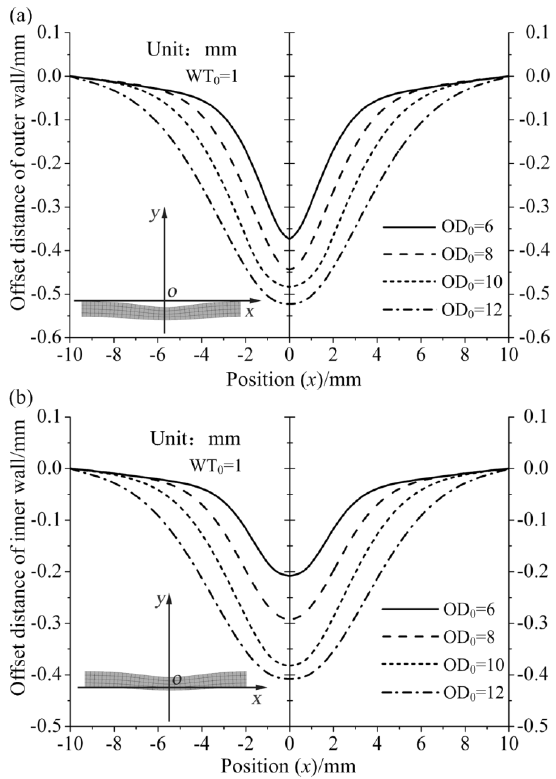
Figure 9. Effect of OD 0 on surface profile at fracture of ( a ) the outer wall and ( b ) the inner wall.